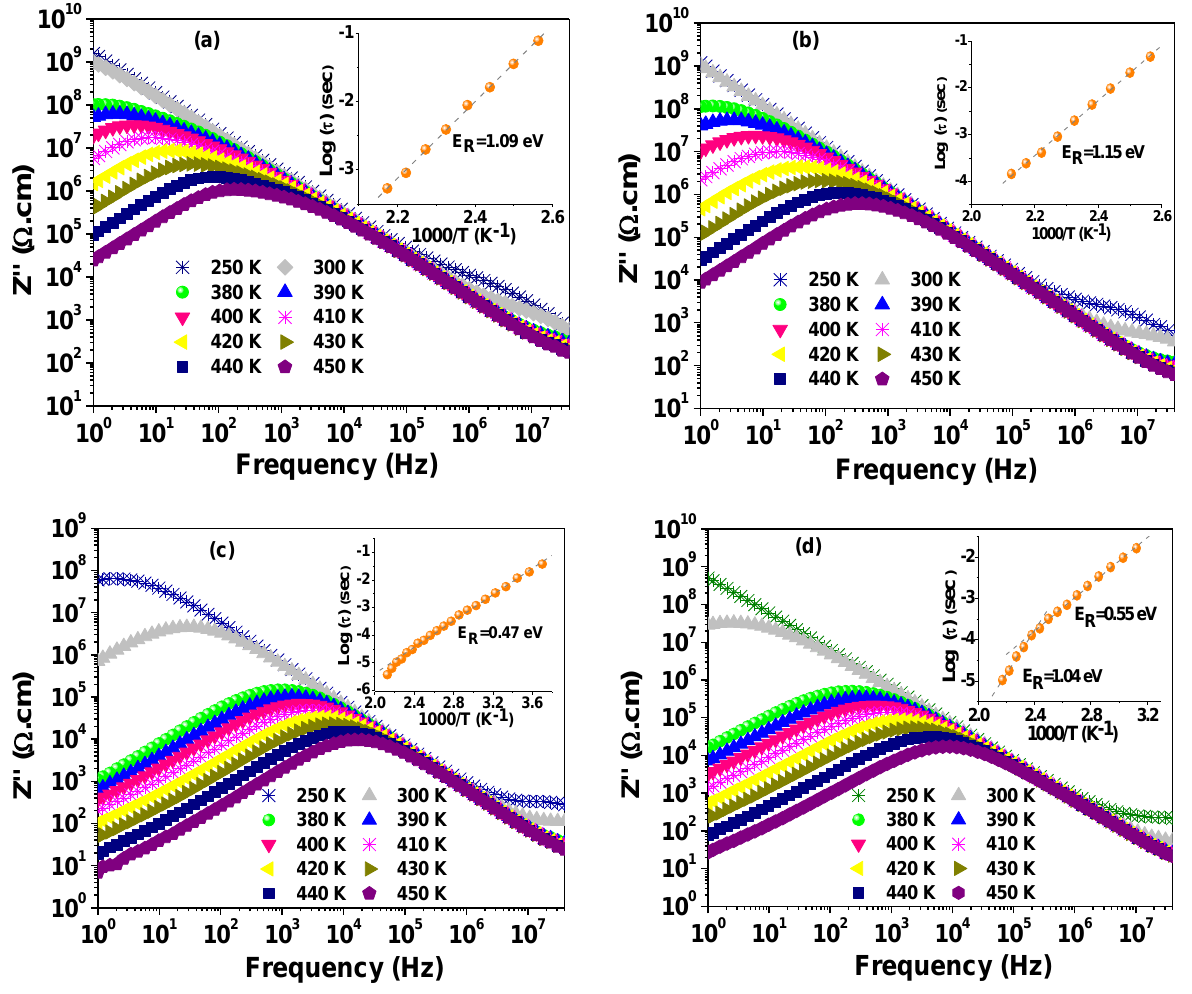
Figure 10. Spectra of Z″ at selected temperatures for ( a ) CS-1000, ( b ) CS-1025, ( c ) CS-1075, and ( d ) CS-1100. The inset of each figure depicts the Arrhenius plot for the relaxation time.